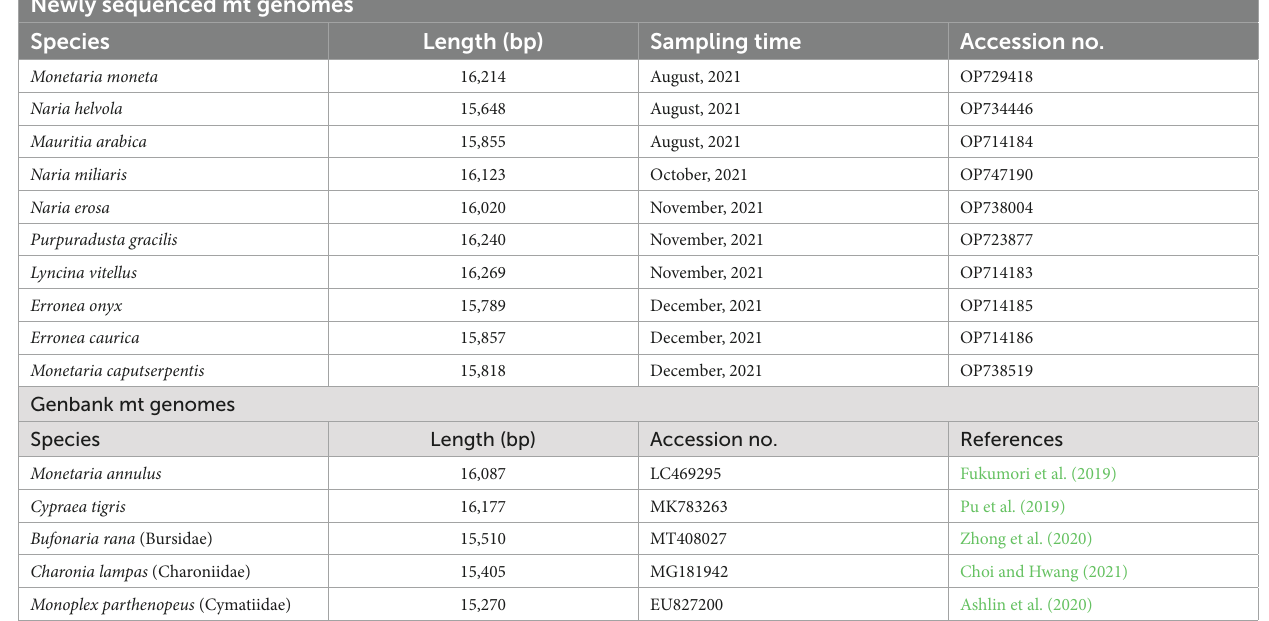
TABLE 1 Mitochondrial (mt) genomes analysed in this study. Newly sequenced mt